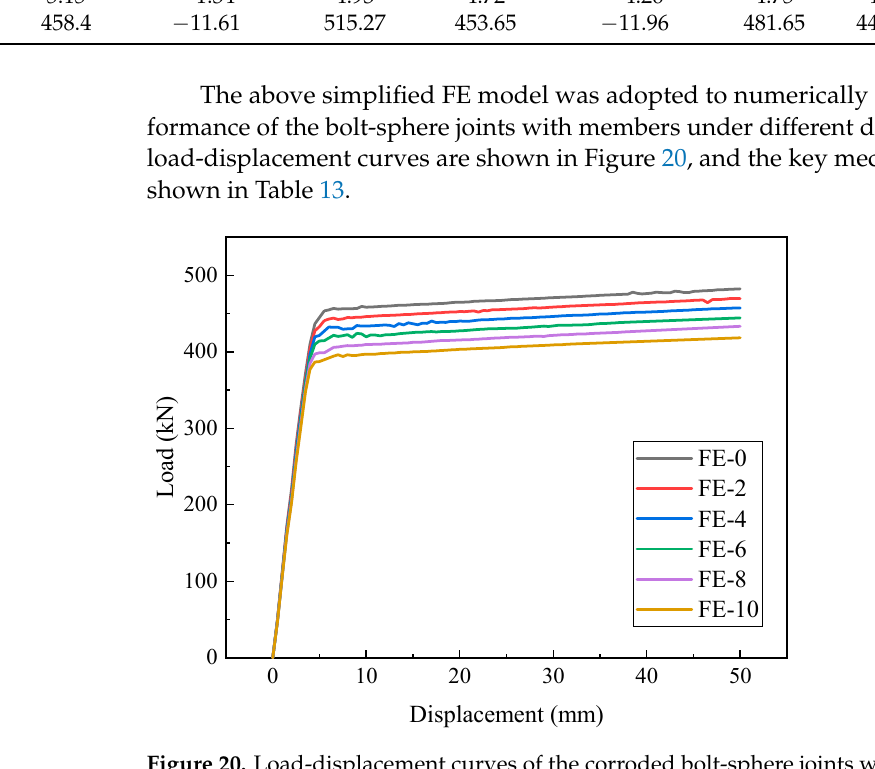
Figure 20. Load-displacement curves of the corroded bolt-sphere joints with members for different degrees of corrosion. Table 13. Mechanical parameters of the corroded bolt-sphere joints with Table 14. Results of normalization analysis on the bolt-sphere joints